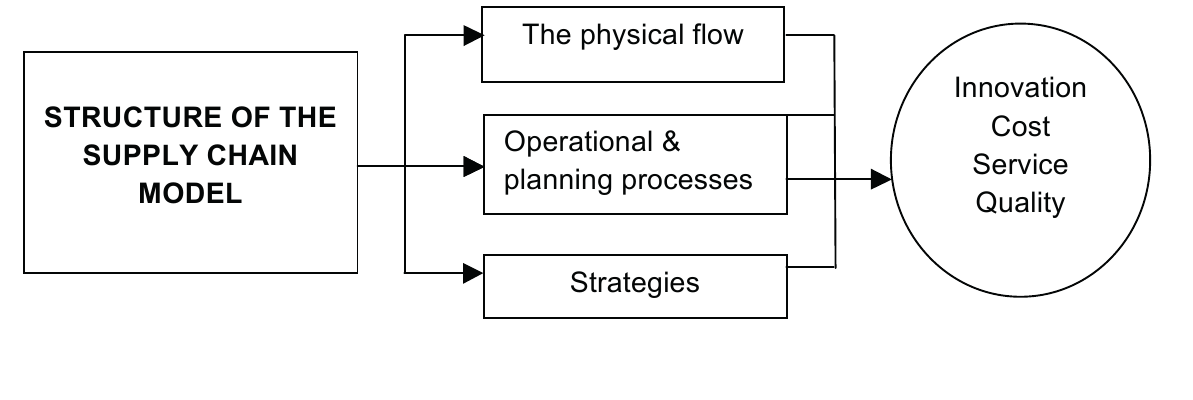
Figure 1: Components of the supply chain model